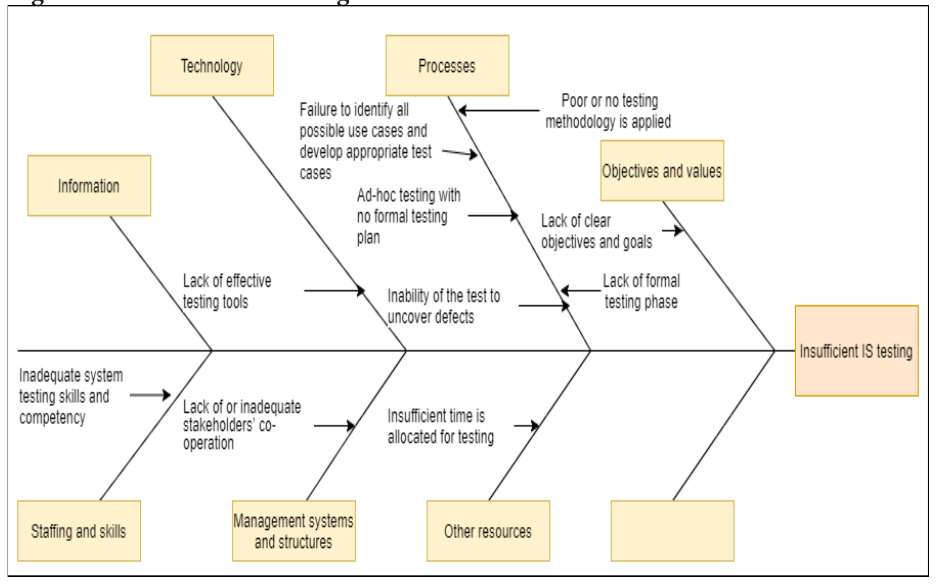
Figure 11: Insufficient IS testing